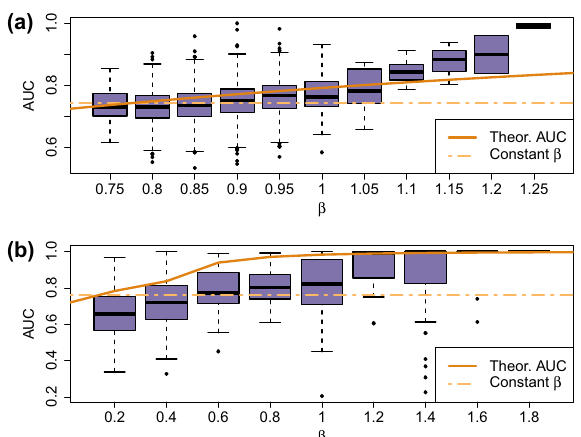
Figure 3. AUC statistics compared to β( t ) in applications of DyNoKIM. ( a ) AUC values for stock price activity on November 19, 2019 aggregated for different values of β( t ) , compared to the theoretical expected AUC with Gaussian g i ( t ) and to the performance with constant β ; ( b ) AUC values for link prediction in the SocioPatterns dataset, compared with the theoretical expected AUC and the constant β